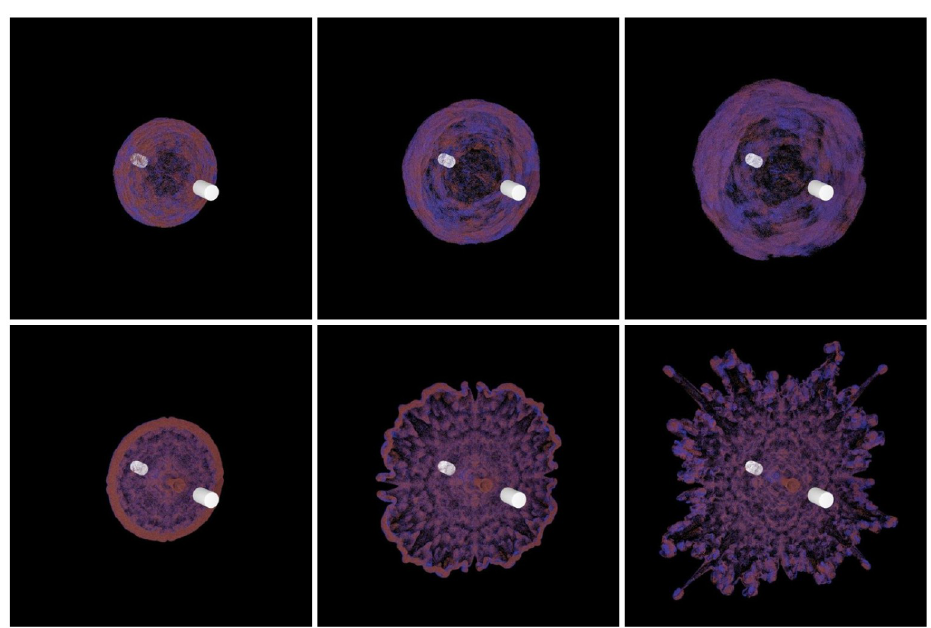
Fig 6. Colliding vortex rings using different methods. The first row: the MacCormack solver; the second row: our method.